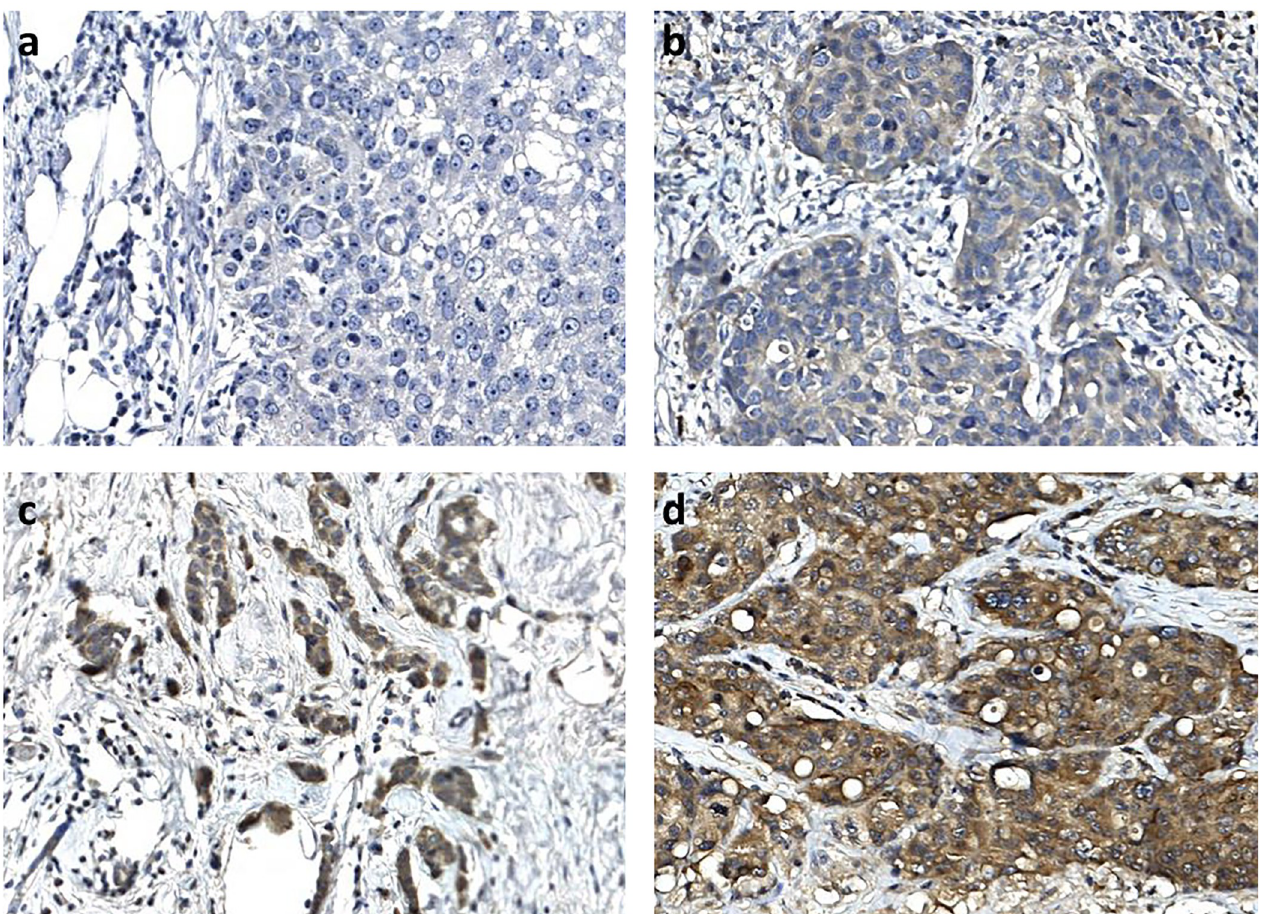
Fig 1. Immunohistochemical expression of eEF1A2 in breast cancer. a: absence of expression (0); b: weak expression (1+); c: moderate expression (2+); d: strong expression (3+). 20x magnification.